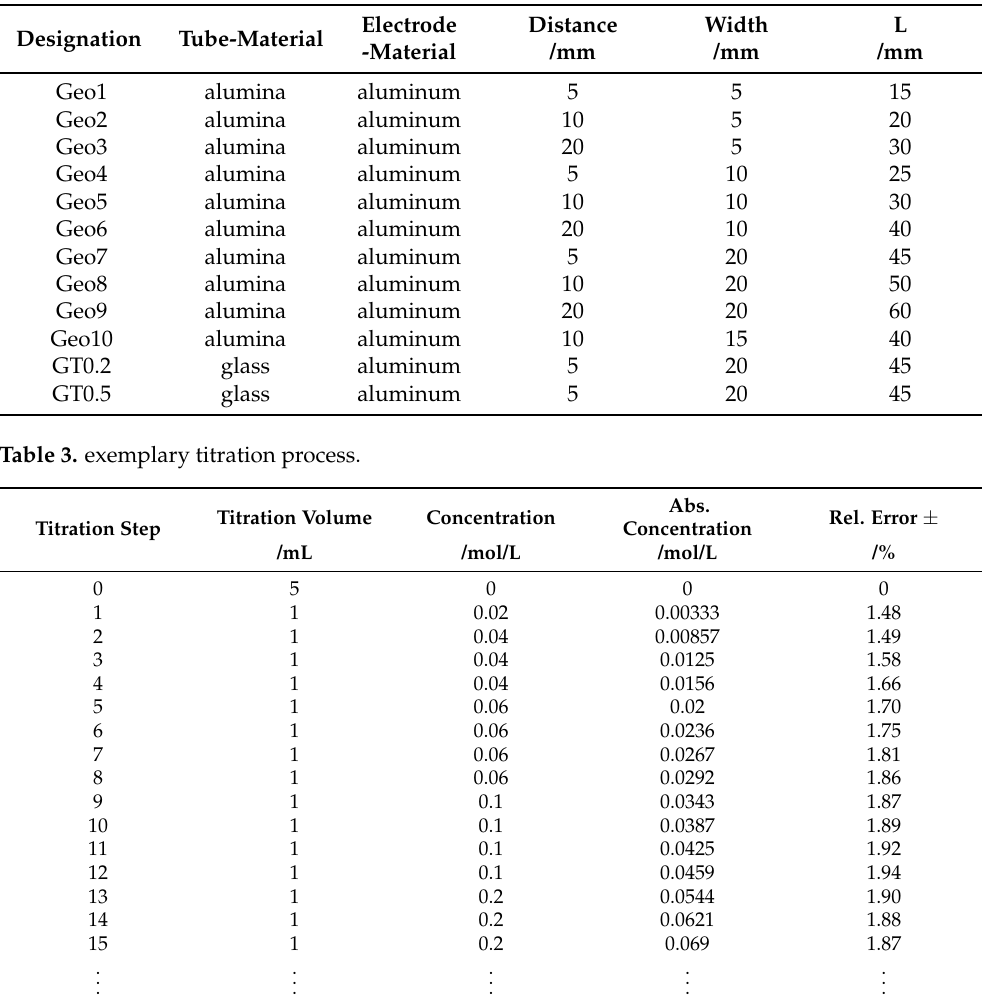
Figure 2. ( left ): Test setup with the (a) HIOKI IM3536 LCR meter, (b) peristaltic pump, (c) magnetic stirrer and (d) the test cell, covered in the faraday cage. ( right ): test cell. Table 2. electrode configuration.